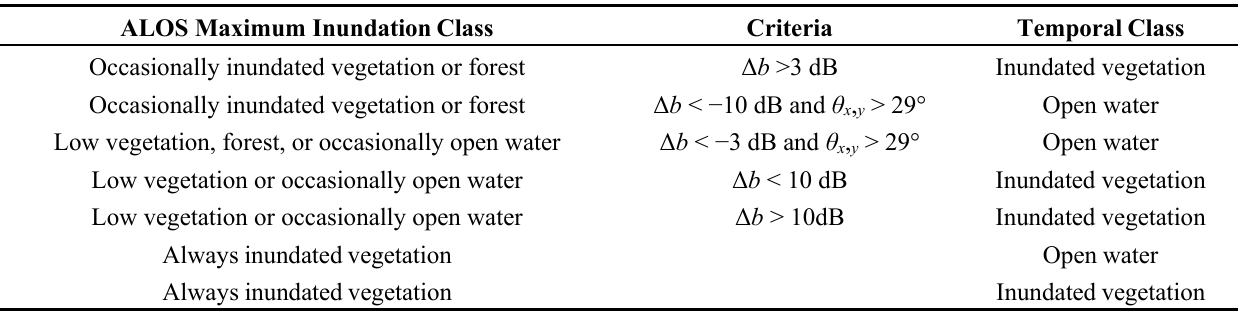
Table 6. Criteria for assessing inundation state for each ALOS ScanSAR